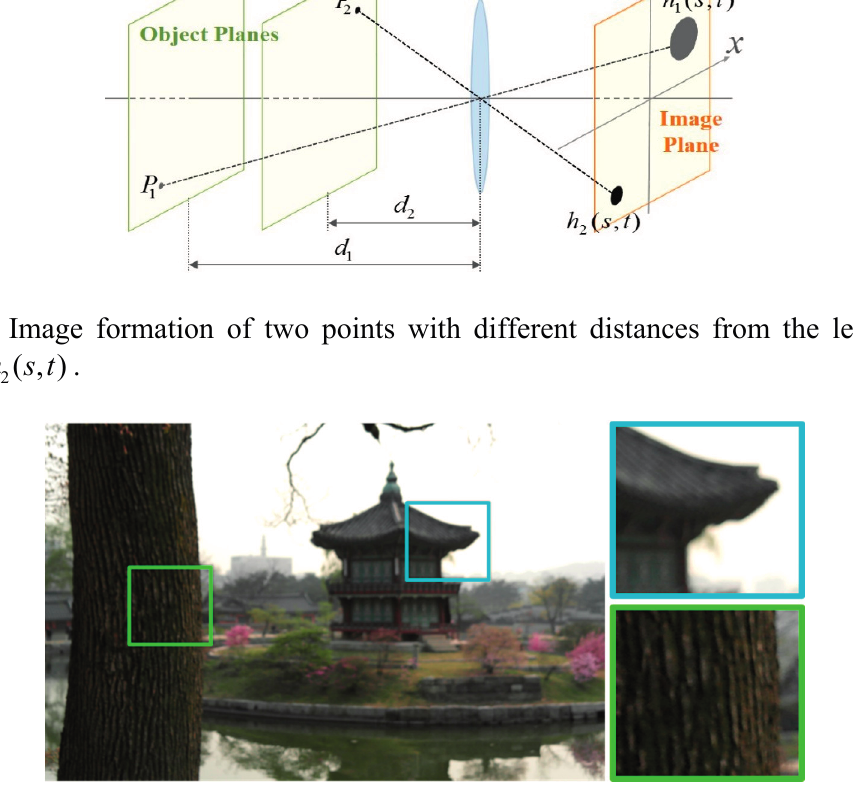
Figure 4. An outdoor image acquired by a digital single lens reflected (DSLR) camera. The gazebo and trunk of the tree are blurred by different